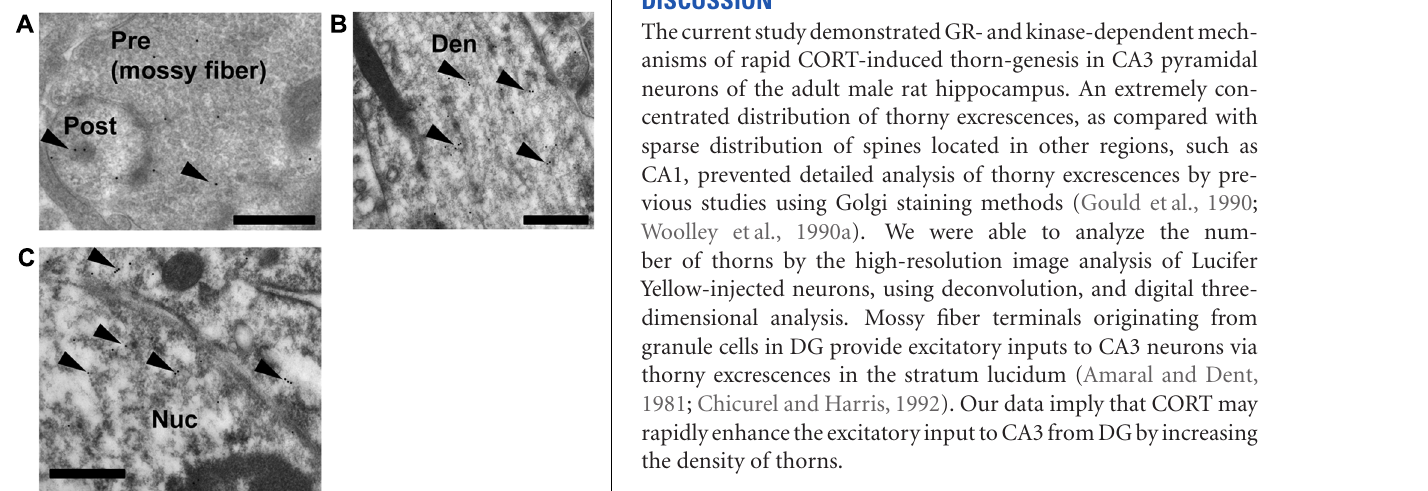
FIGURE 5 | Immunoelectron microscopic analysis of the distribution of GR within the mossy fiber synapses, dendrites in stratum lucidum and nuclei of pyramidal cells in CA3 region. Gold particles (arrowheads), specifically indicating the presence of GR, were localized in the pre- and postsynaptic regions (A) . In dendrites, gold particles were often found in the cytoplasmic space (B) . Gold particles were also localized in the nuclei (C) . A search for immuno-gold labeled GR proteins was performed at least 30 synapses at CA3 region from more than 100 independent images. A 1:3000 dilution of IgG was used to prevent non-specific labeling. Pre, presynaptic region; Post, post synaptic region; Den, dendrite; Nuc, nucleus. Scale bar, 500